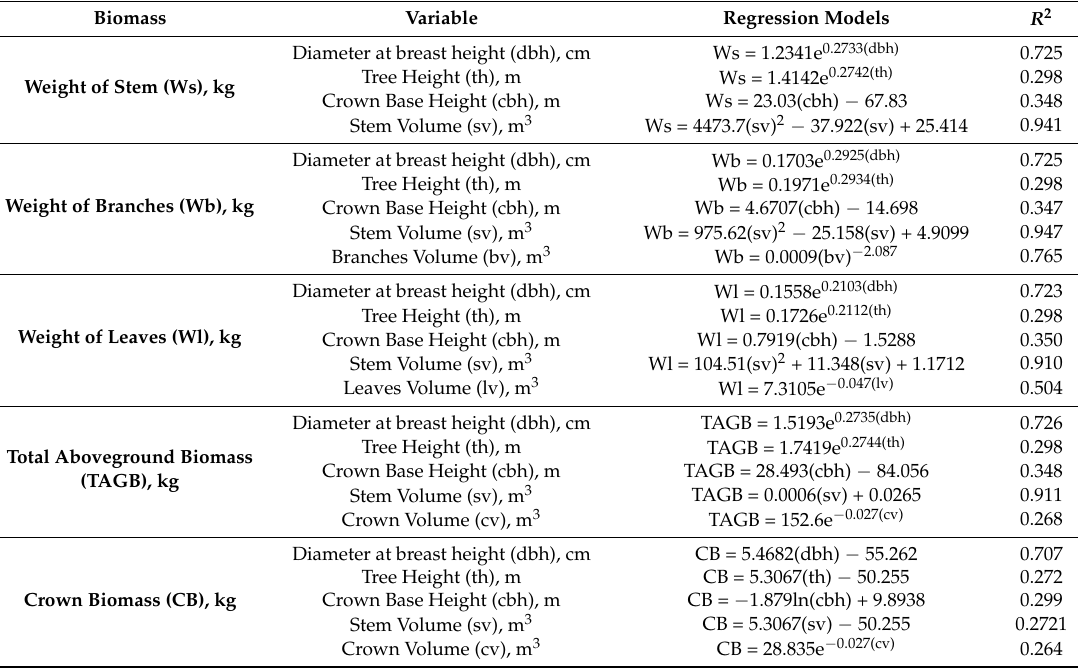
Table A7. Allometric equation generated for Mempening with tree variables obtained from